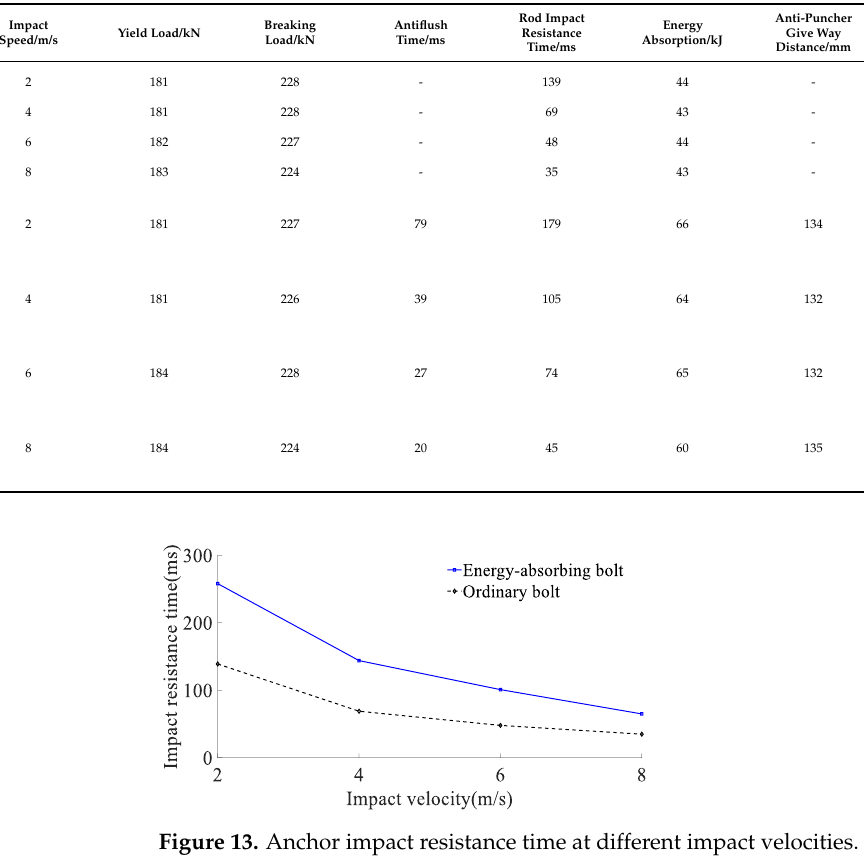
Figure 12. Anchor energy absorption – displacement curve. Table 3. Mechanical properties of anchor rods at different impact velocities.